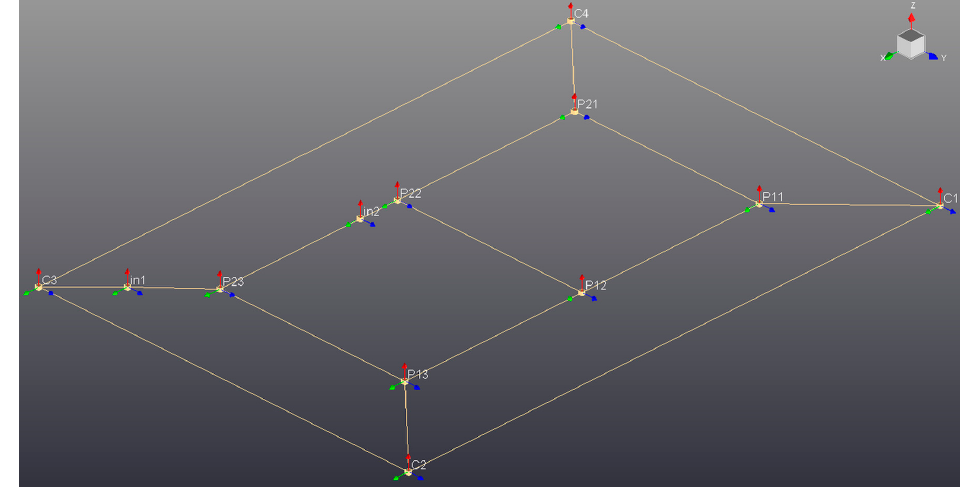
Figure 3. Geometry of the modal model: C2 – C4 are active in the impact tests only; in1 and in2 are active in the shaker tests only.